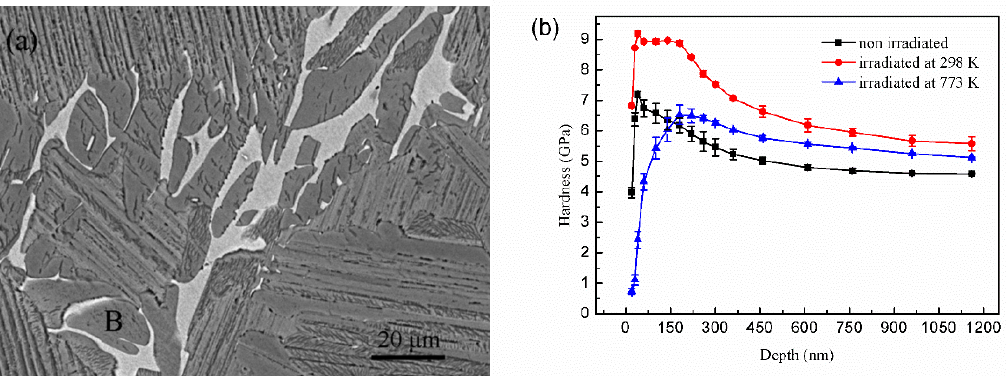
Figure 8. Nanoindentation hardness of the experimental high Nb-containing TiAl alloy. ( a ) The position of nanoindentation tests in the alloy: B γ phase. ( b ) The curve of nanohardness with depth in the γ phase before and after ion implantation of as-cast alloy.